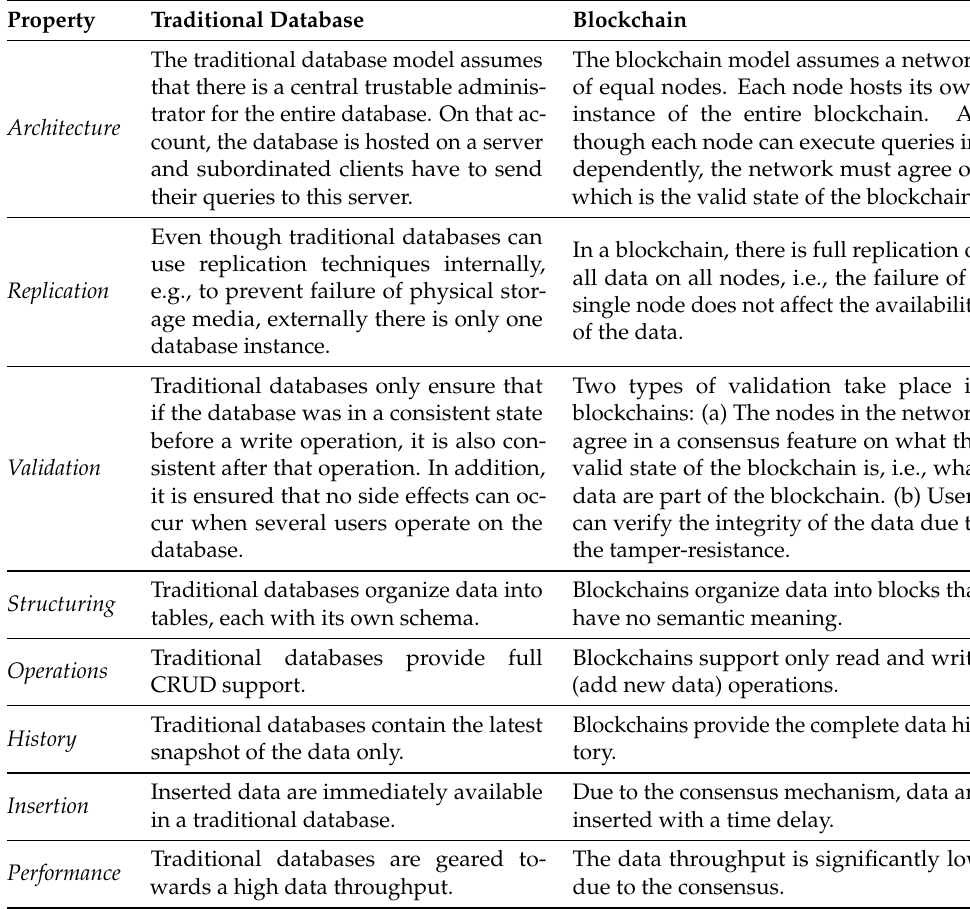
Table 1. Main differences between traditional databases and